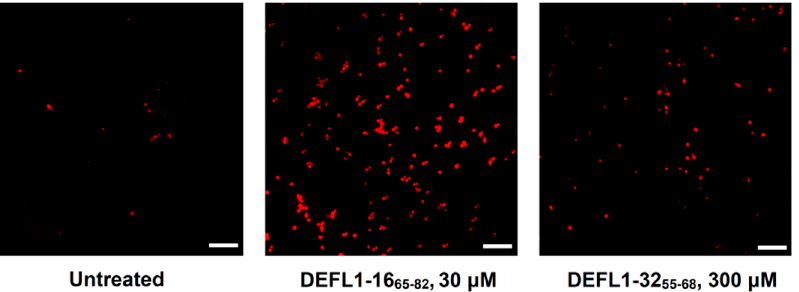
Figure 7. Fluorescence microscopy images of C. albicans cells incubated in the presence of peptides and stained with propidium iodide. Untreated C. albicans cells were used as a negative control. Scale bar = 20 μ m.